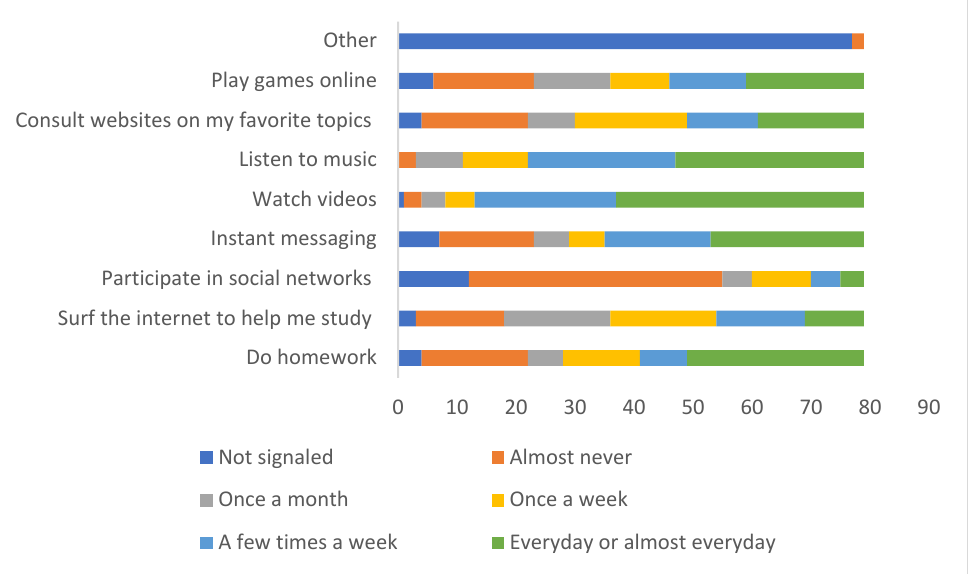
Figure 6. 5th grade s tudent’s activities online .